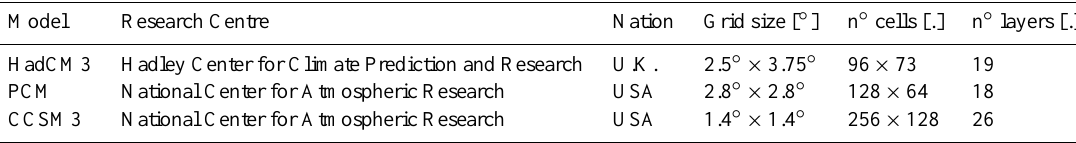
Table 2. Description of GCM